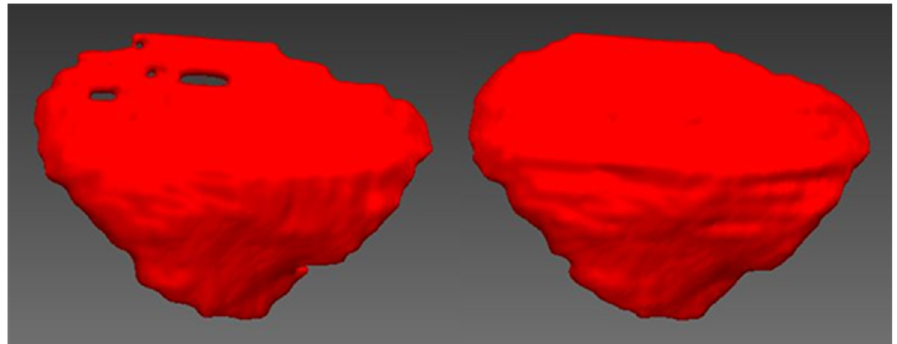
Figure 8. The patient-specific cranial implant with every tenth slice interpolation ( left ) and every fifth slice interpolation ( right ).